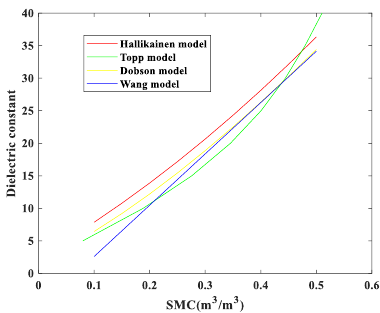
Figure 15 . The four soil models on Chinese loamy clay （ C=0.37 ， S=0.55 ） .